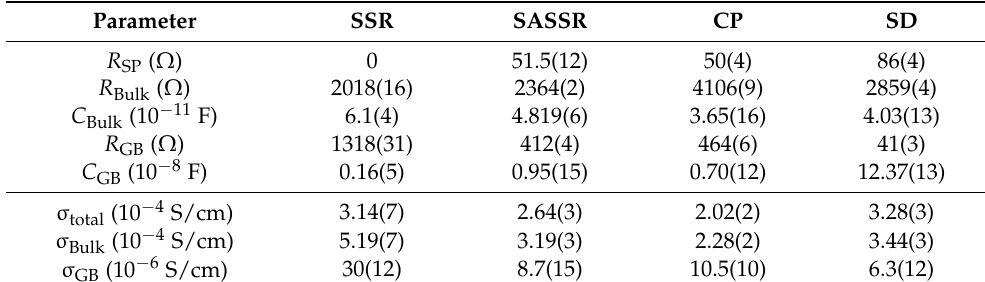
Table 4. Fitted resistances, calculated capacitances, and the total, bulk, and grain boundary conduc- tivities for the different